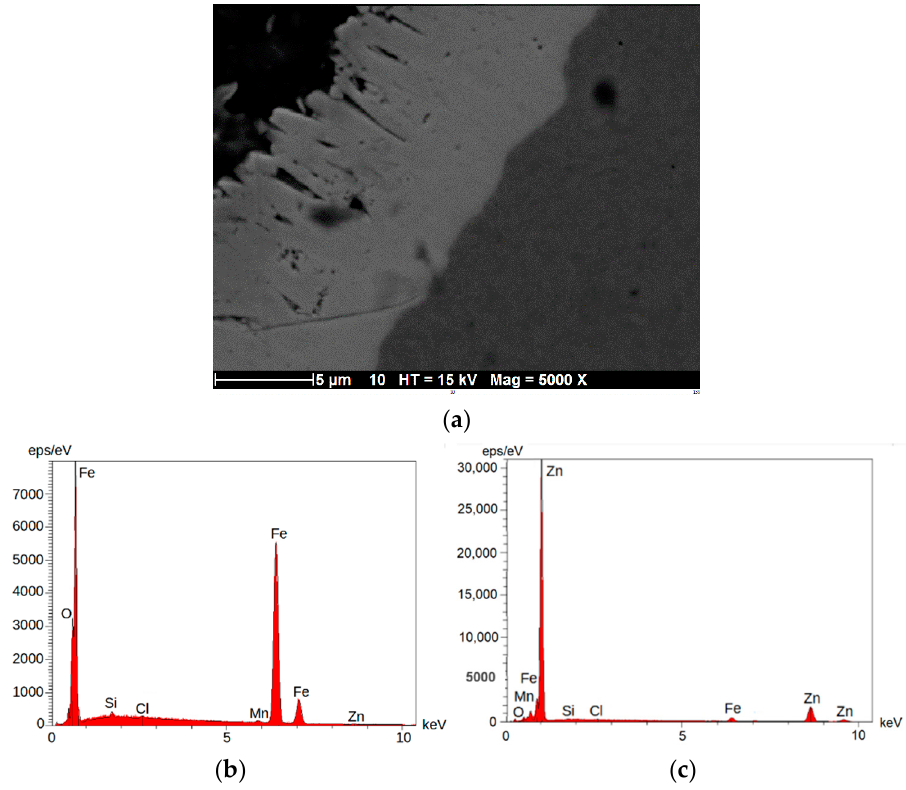
Figure 11. Spectroscopy analysis for an uncorroded steel wire: ( a ) Microscopic view; ( b ) steel substrate; and ( c ) galvanization layer.